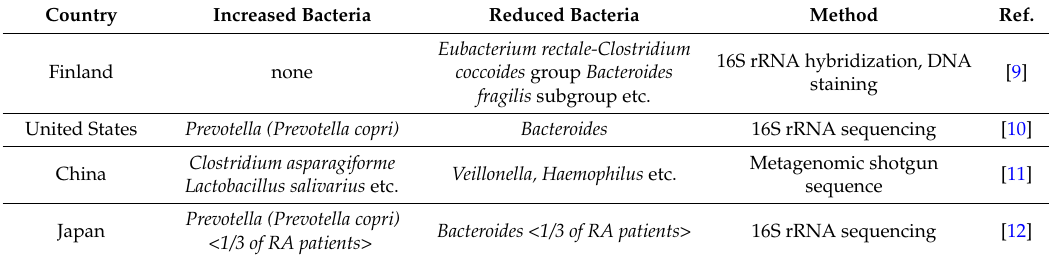
Table 2. Altered composition of intestinal microbiota observed in human RA